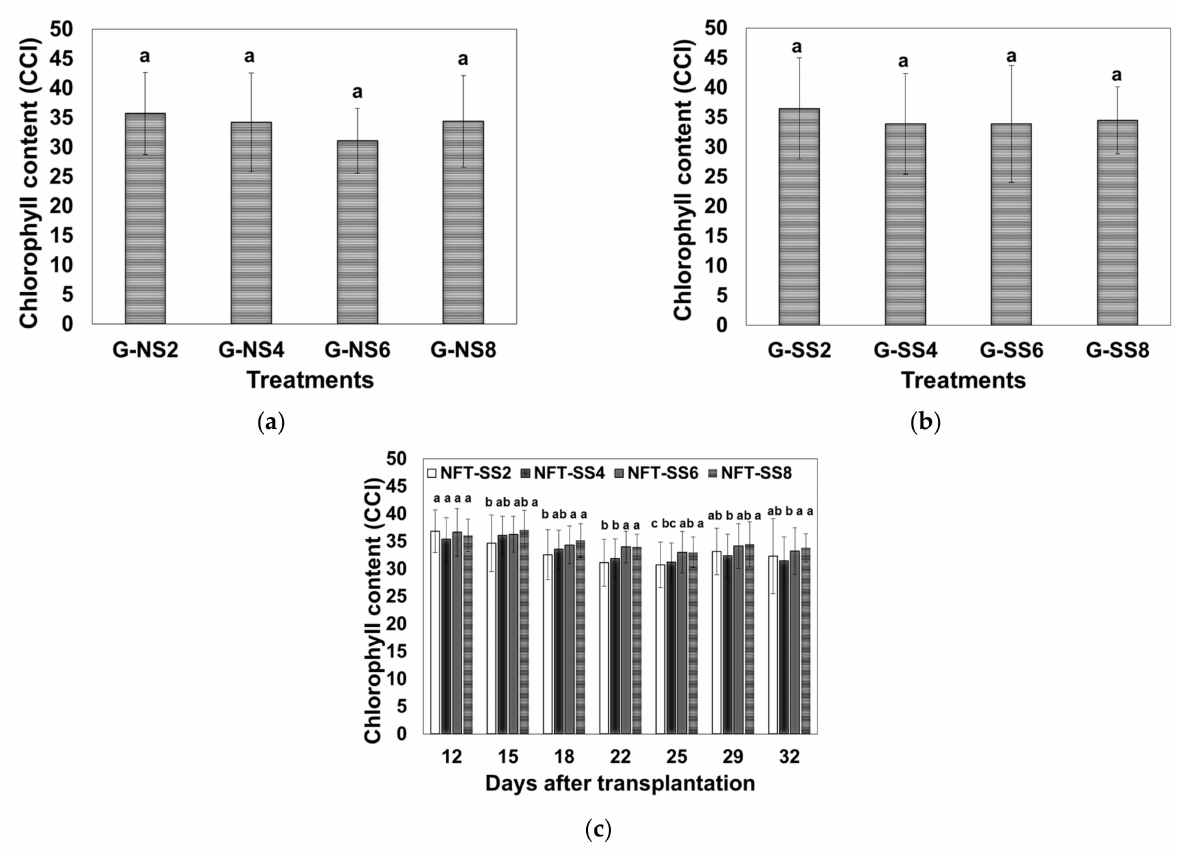
Figure 5. Mean chlorophyll content (CCI) of basil leaves irrigated by means of a ( a ) G-NS, or ( b ) G-SS during the first period and ( c ) NFT-SS during the second period. Means followed by different lowercase letters (a, b, c) differ significantly according to the Tukey–Kramer HSD test at p < 0.05 across the fertigation